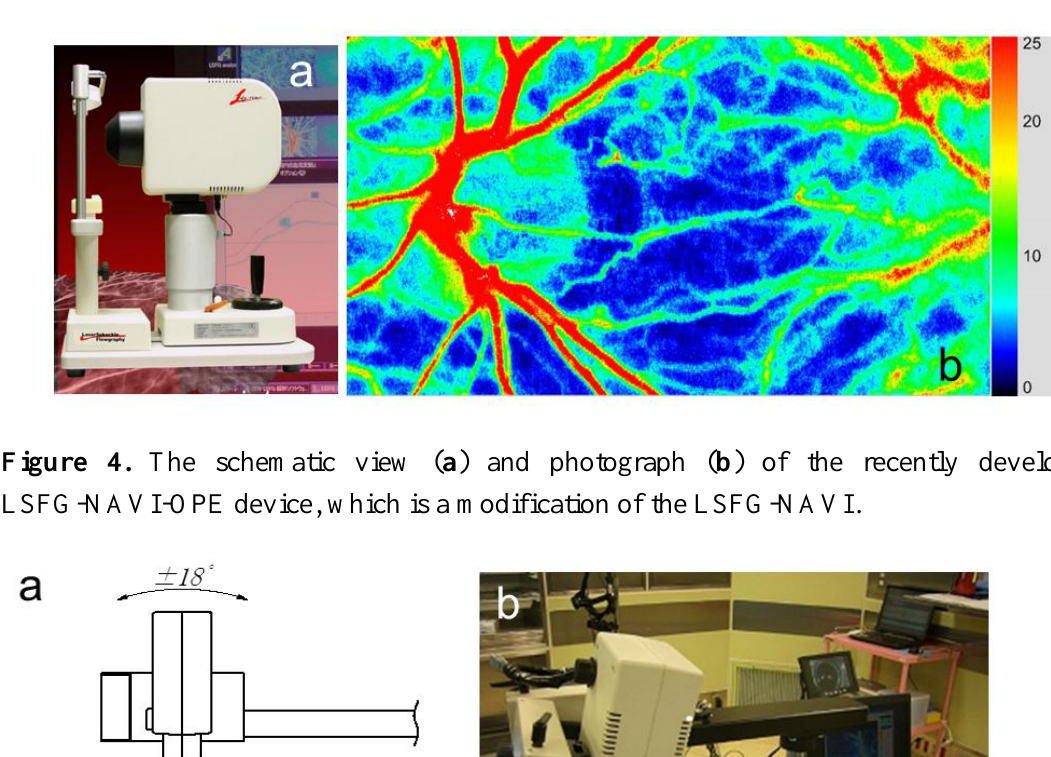
Figure 3. Appearance of the LSFG-NAVI device ( a ) and an example of its color map ( b ).